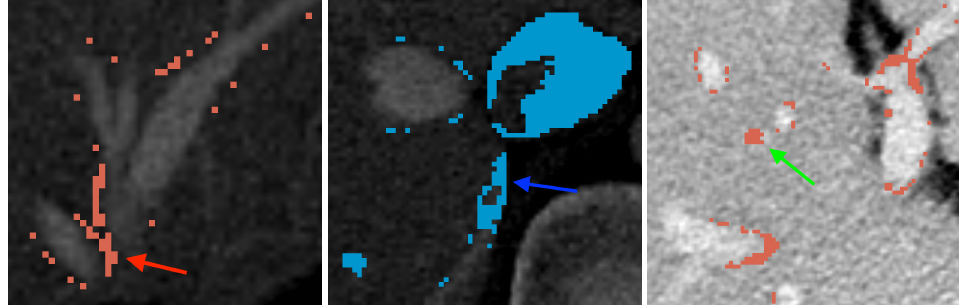
Figure 12. Left image—an example of oversegmentation in the borders of the vessels with a vessel fusion in the bifurcation (red arrow). Middle image—undersegmentation disrupting vessel continuity (blue arrow). Right image—an example of a segmented vessel which was not detected and segmented in the ground truth (green